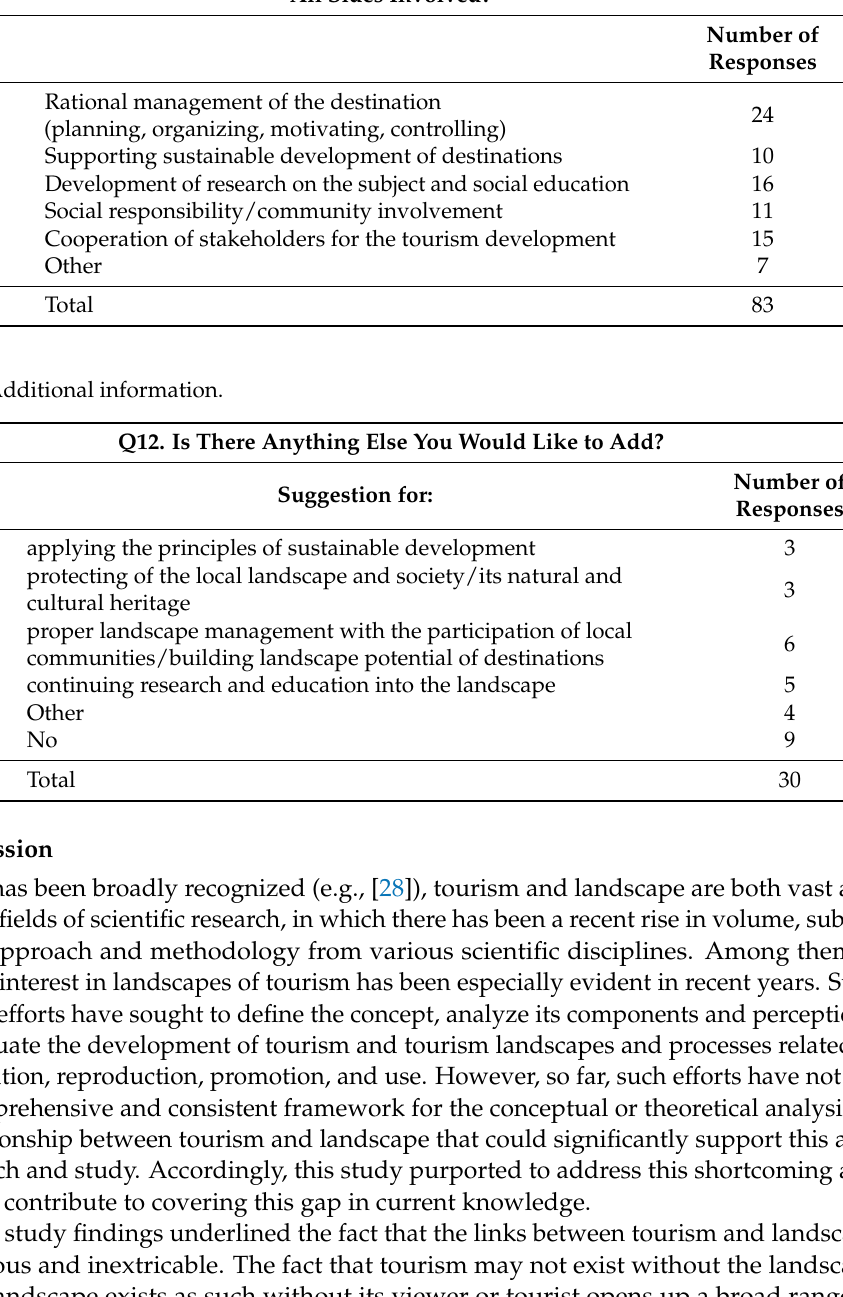
Table 5. Proposals for optimising the tourism–landscape relationship.